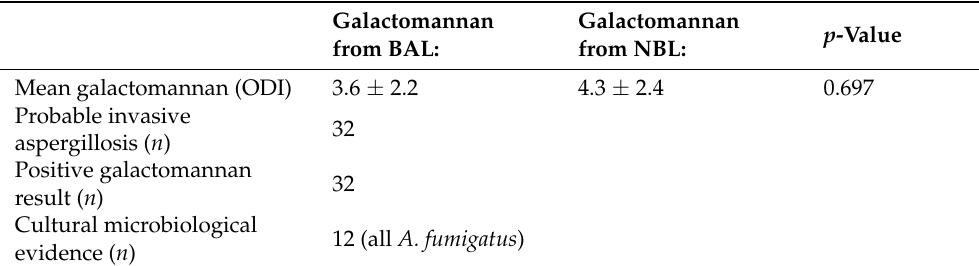
Table 2. Results of galactomannan-antigen testing from bronchoalveolar lavage fluid and tracheal